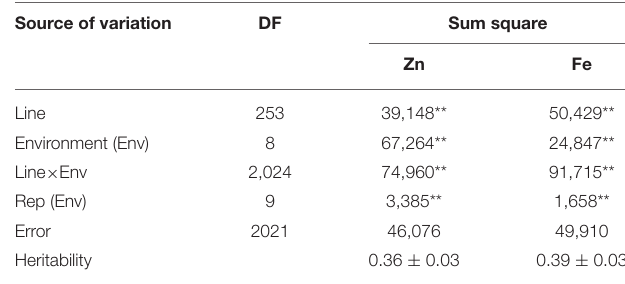
TABLE 1 | Analysis of variance of GZn and GFe in 254 RILs derived from the cross Jingdong 8/Bainong AK58 grown in nine environments. Source of variation